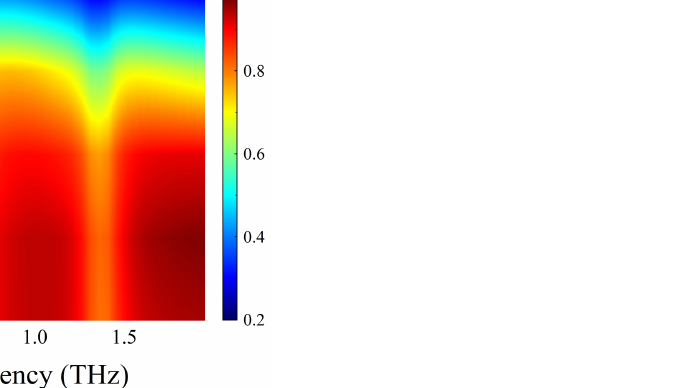
Figure 11. Transmission spectra of the AIGS covered with lactose at different incidence angles θ under TM